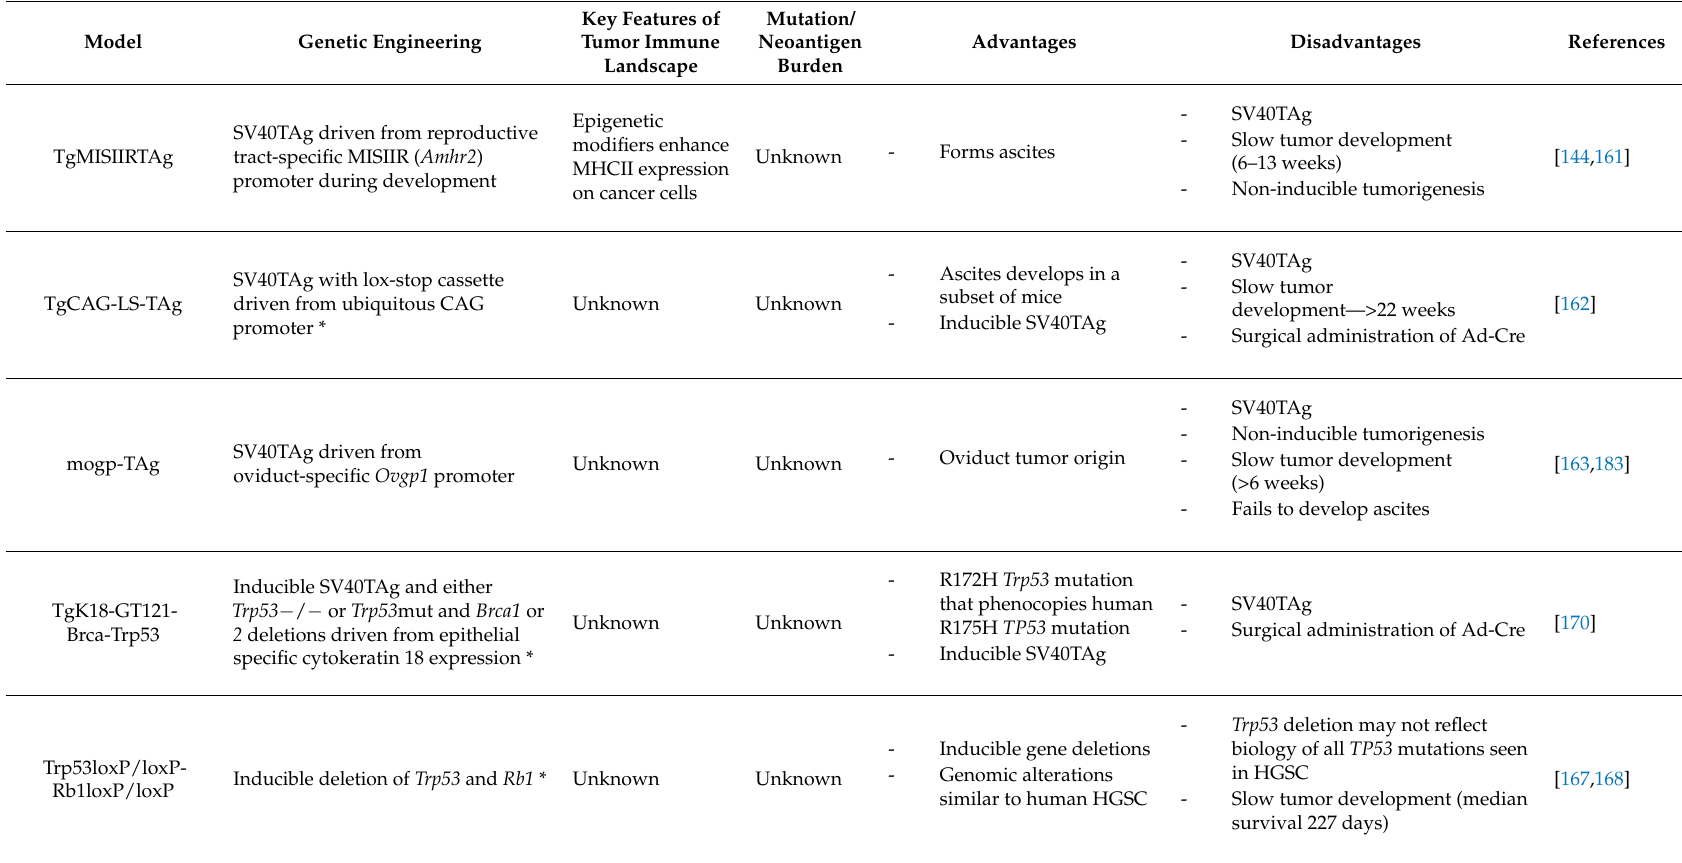
Table 3. The utility of genetically engineered mouse models (GEMM) of ovarian